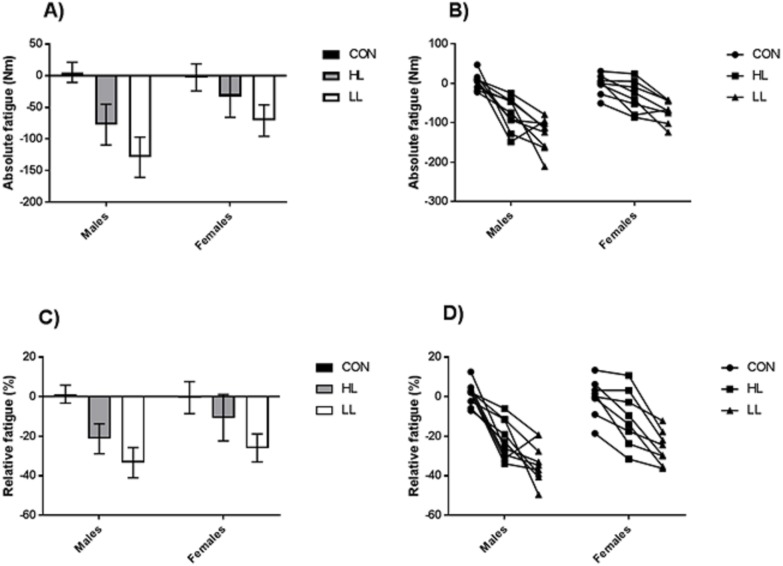
Mean ±95% CIs (A) and individual responses (B) for absolute fatigue, and mean ±95% CIs (C) and individual responses (D) for relative fatigue, between conditions and sexes.